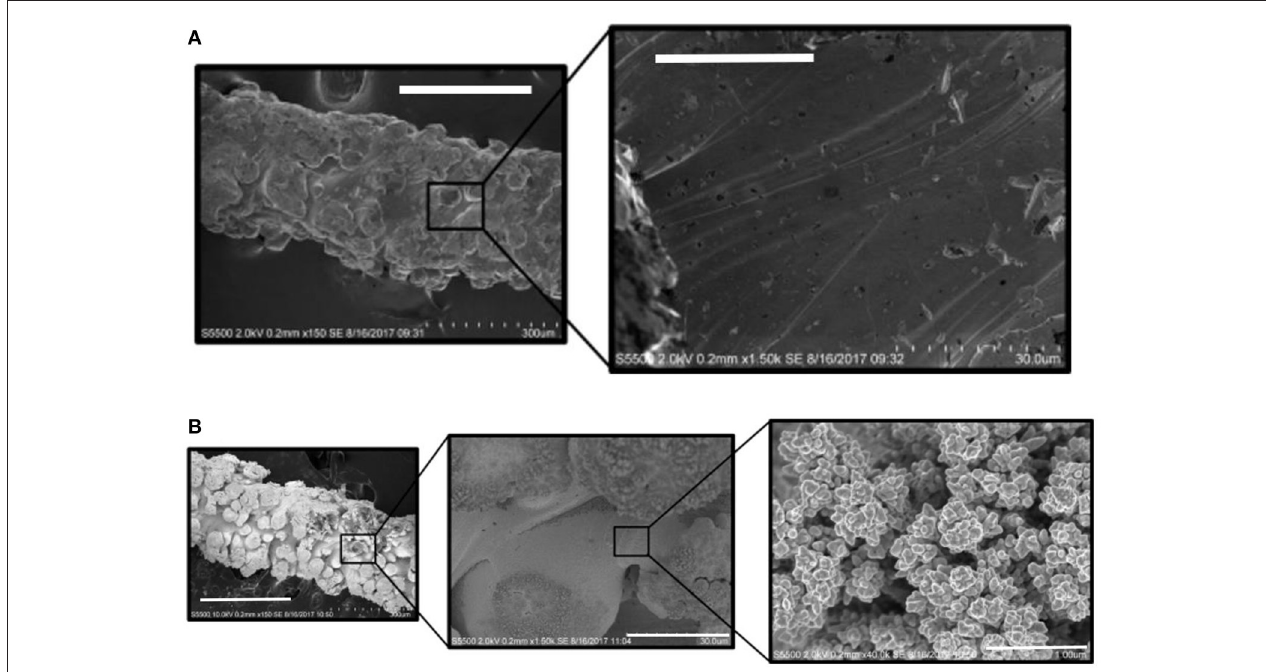
FIGURE 1 | Secondary electrons HR-SEM micrographs showing (A) 3D Ti and (B) Au-coated 3D Ti electrodes, at low and high magnifications, using accelerating voltages that range from 2 to 10 kV, respectively. The scale bars are: (A) Left to right: 300 and 30 µ m. (B) Left to right: 300, 30 and 1 µ m.